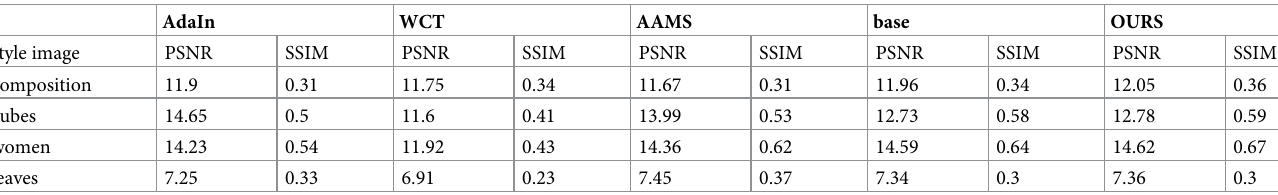
Table 2. Comparison of quantitative indices between the various methods. AdaIn